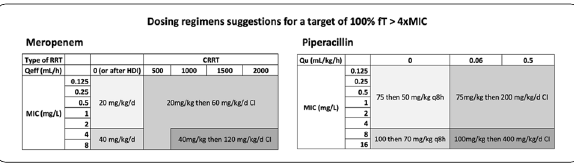
Fig. 1 Dosing regimens suggestions for a target of 100% fT >